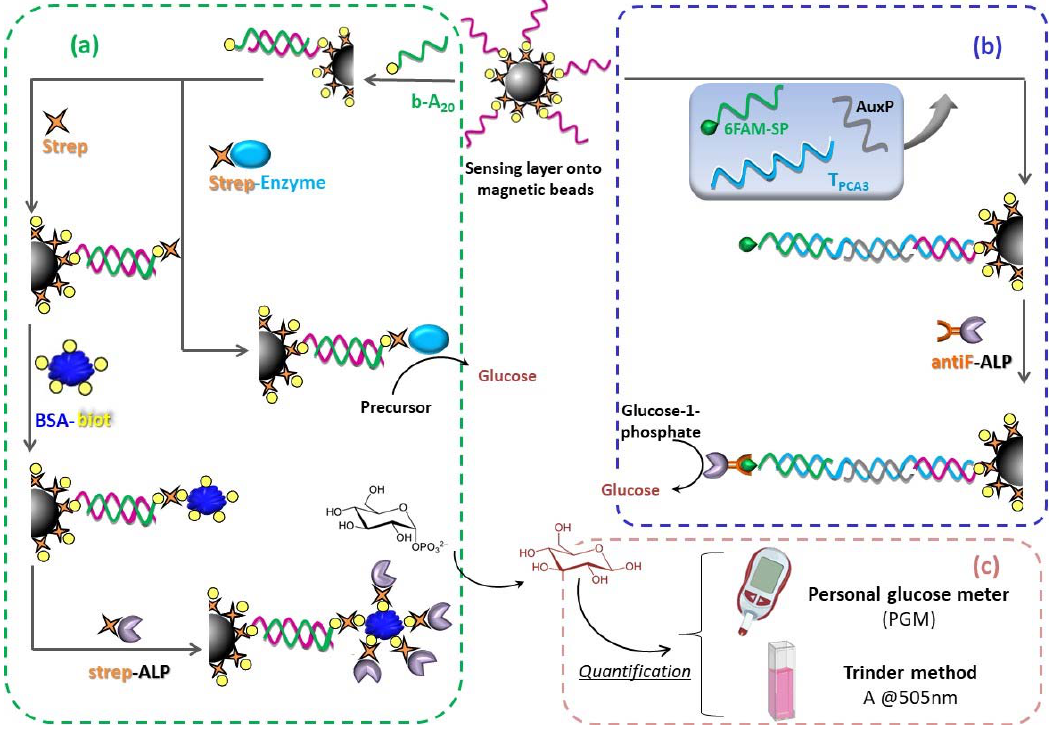
Figure 1. Schematic depiction of the hybridization-based bioassay. ( a ) Proof-of-concept direct genoassay for the detection of a model target b-A 20 ; with / without amplification strategy based on multivalent system biotin-streptavidin. ( b ) Sandwich genoassay for the detection of T PCA3 . Note that more than one capture probe is immobilized onto each MB but, for the sake of clarity, the figure only shows one DNA strand. ( c ) Quantification step, either with the personal glucose meter or spectrophotometrically.